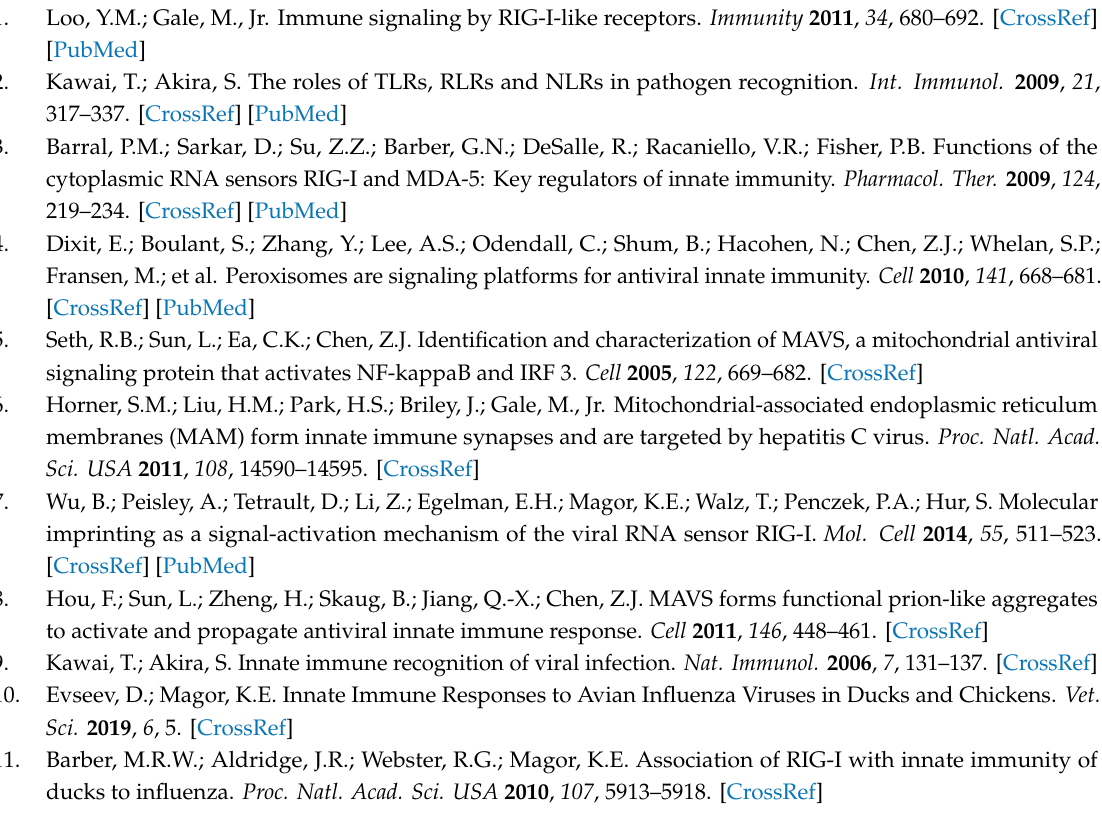
Table S1: Primer list, Table S2: Accession numbers for MAVS proteins, Figure S1: PB1-F2 inhibits human RIG-I-CARD